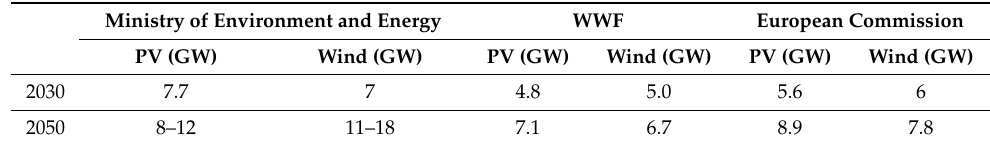
Table 1. Forecasts for the cumulative capacity of PV and Wind capacity in Greece by 2030 and 2050